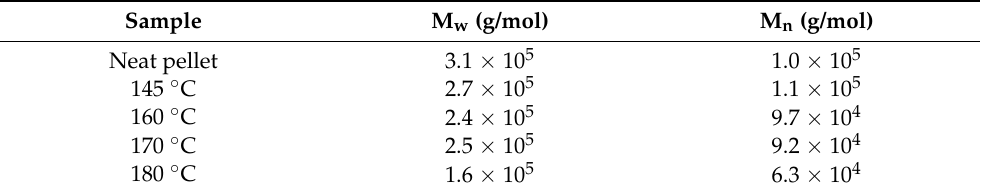
Table 8. Molecular weight details (M w and M n ) of PHBHHx pellets and samples produced at P = 145 ◦ C, 160 ◦ C, 170 ◦ C, and 180 ◦ C determined with GPC